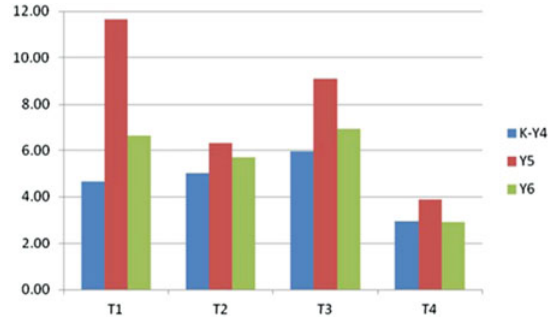
(Colour online) Mean weighted absences for non-Indigenous stu- dents K-4 combined, compared with Year 5 and Year 6, for each school term.